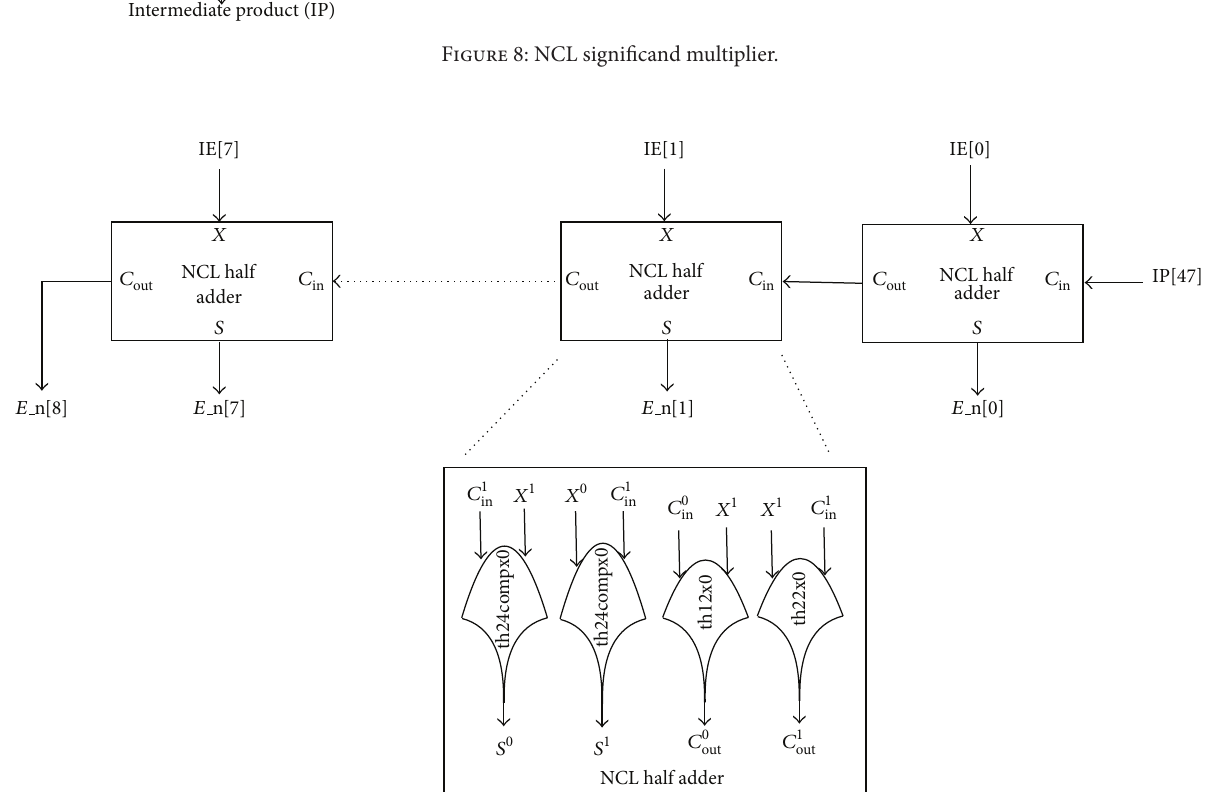
Figure 8: NCL significand multiplier.